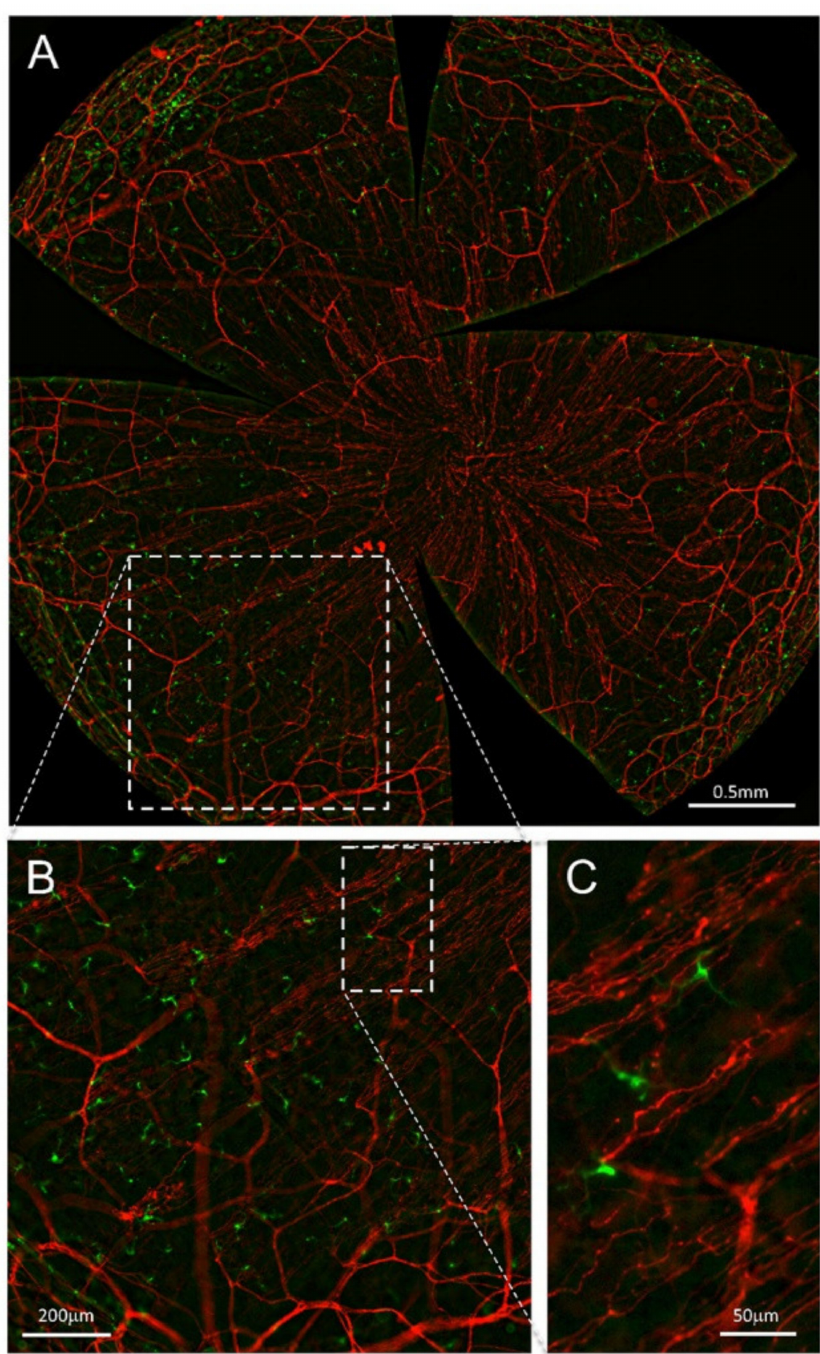
Figure 8. Nerves and DCs in the advillin-Cretg/+ Ai14fl/- CD11c-DTR-GFPtg/+ mouse cornea. All panels are maximal intensity z-projection stacks (30 µ m) performed with a Leica THUNDER Imager Tissue provided with a 20 × objective. ( A ) Flat mount overview of a whole-mount cornea (64 tiles merged) showing tdTomato (red) expression in corneal sensory nerves and GFP (green) expression in DCs after computational clearing of the out-of-focus blur. ( B , C ) Higher magnification images showing nerve fibers and DCs endogenously expressing tdTomato and GFP, respectively. Scale bars: A, 500 µ m; B, 200 µ m; C, 50 µ m. Methods: Ocular globes from 5-month-old mutant mice were fixed for 2 h at RT in 4% paraformaldehyde in PBS and then washed in PBS. After washing, corneas were dissected and flat-mounted with